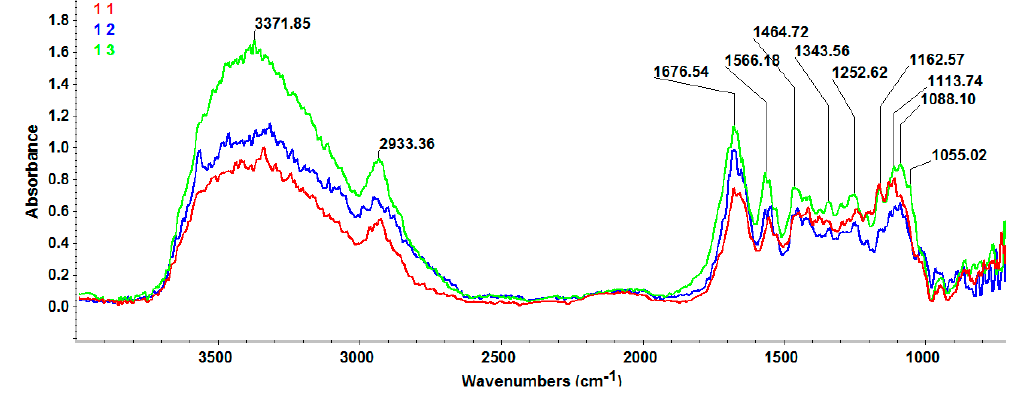
Figure 2. FT-IR spectra of the 3D anti-infective regeneration matrix.